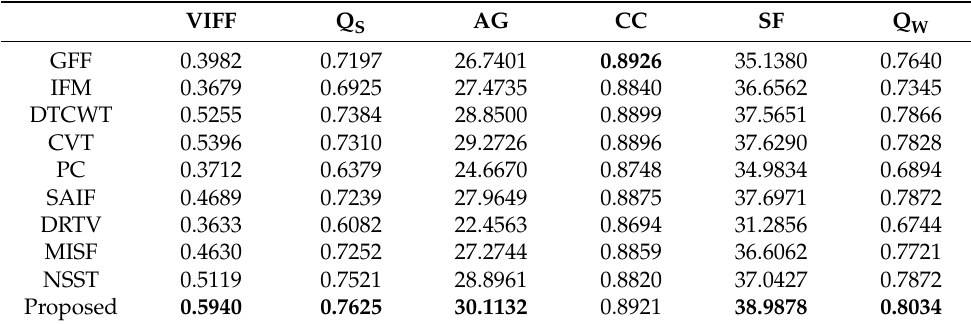
Table 2. The objective evaluation of the methods in Figure 5.